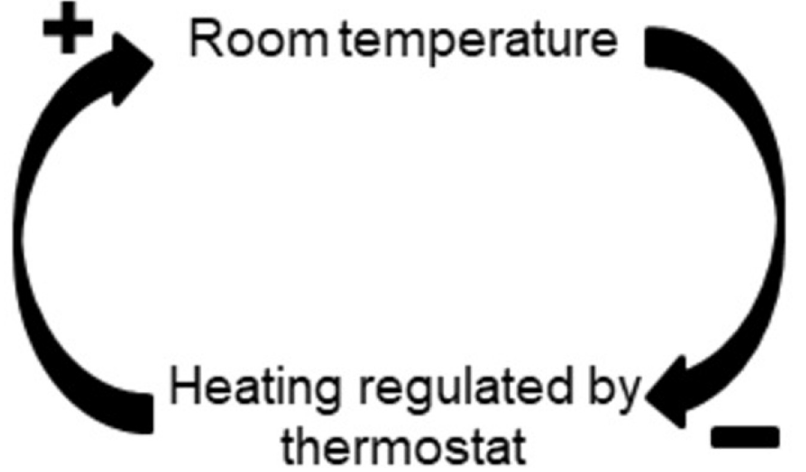
Fig 1. Causal loop diagram example. Thermostat room temperature regulation as a (simplified) example of a causal loop diagram.